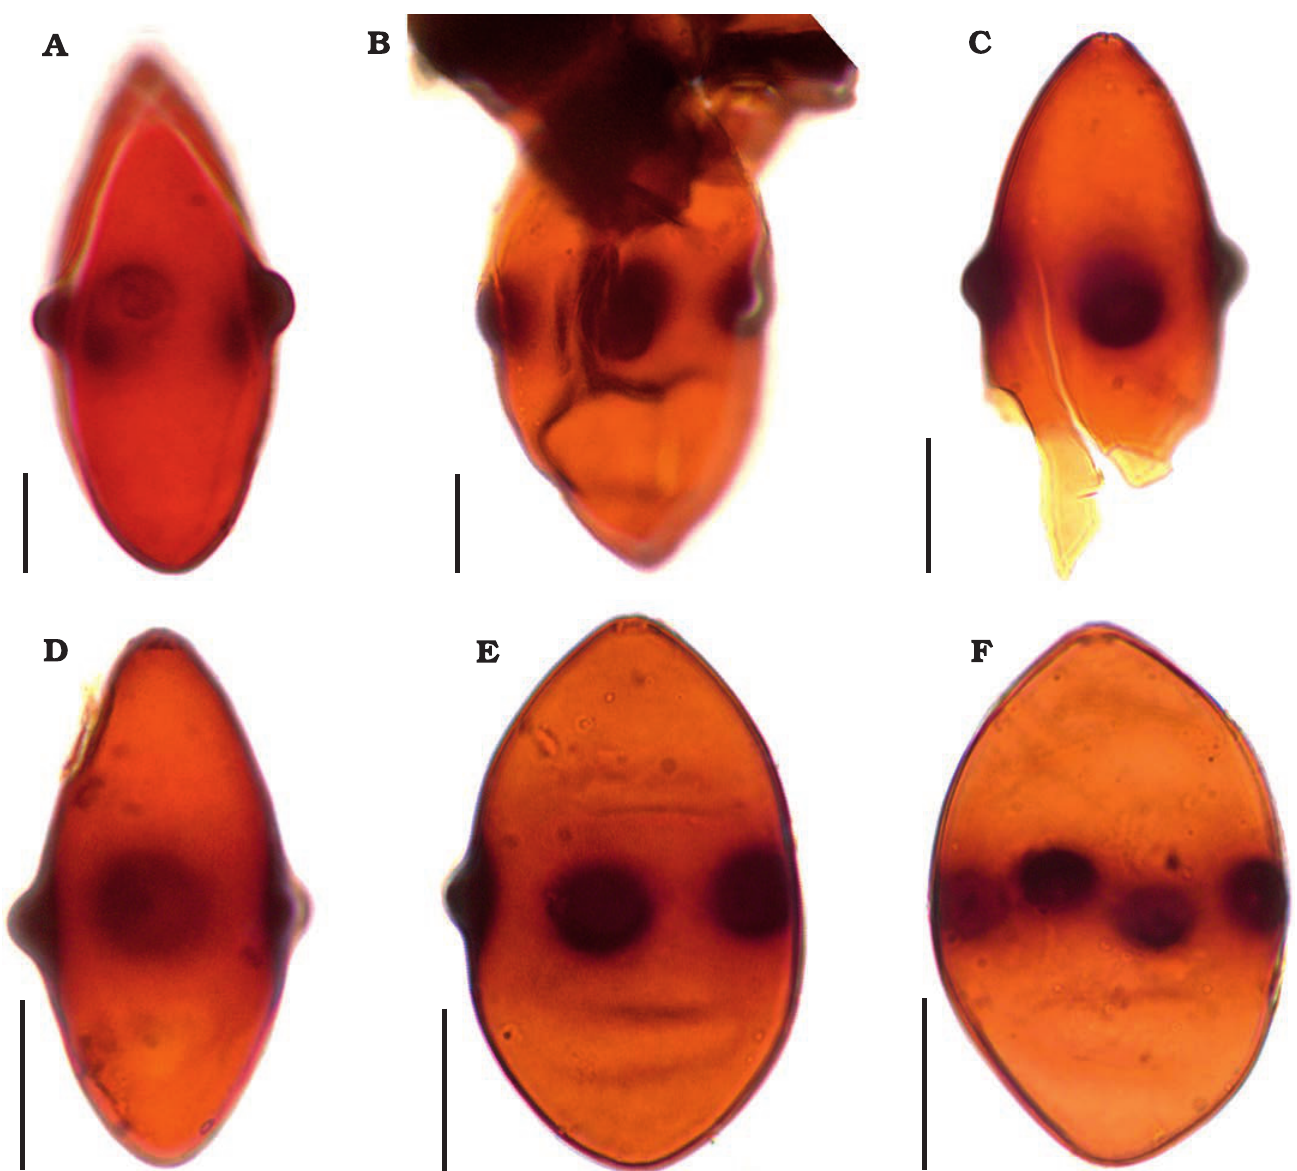
Fig. 2. Fossil ascospores of Potamomyces sp. ex gr. P. armatisporus Hyde, 1995, from Middle (A, B, D–F) and Middle/Upper (C) Miocene of